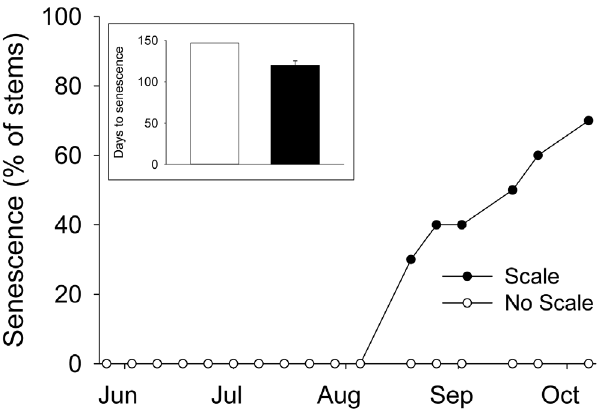
Figure 2. Scale effects on the timing of Spartina senescence during the 2011 field experiment. Senescence is reported as the cumulative percentage of stems senesced at each time point. Inset shows the number of days until Spartina senescence for No Scale (white bar) and Scale stems (black bar). Stems not senescing at the termination of the experiment were assigned a senescence date of 10/14/11. Because all 10 No Scale stems fell into this category but only 3 Scale stems did, the difference in days to senescence is conservative. This also explains the lack of error bars associated with the No Scale inset. Values in inset are means 6